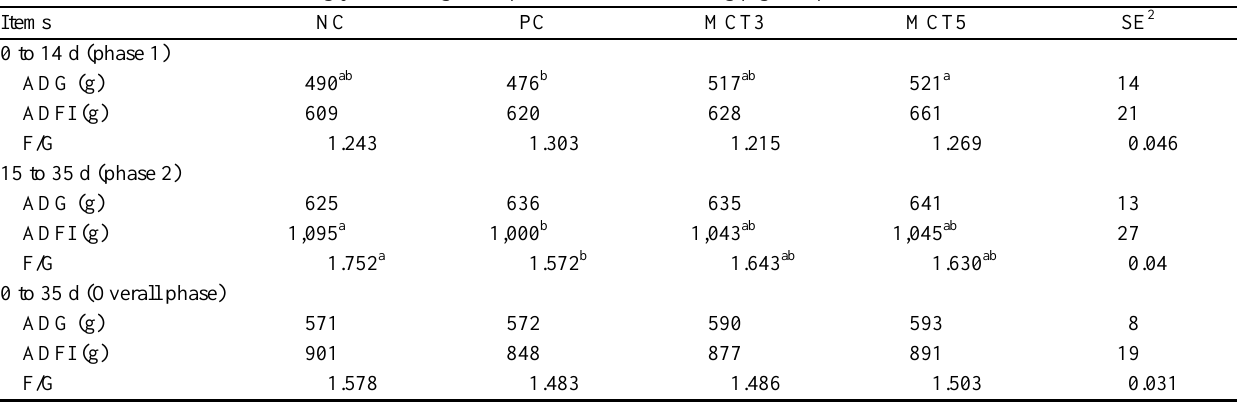
Table 5. Effect of medium-chain-triglyceride on growth performance of weanling pigs (Exp. 2) 1 Items